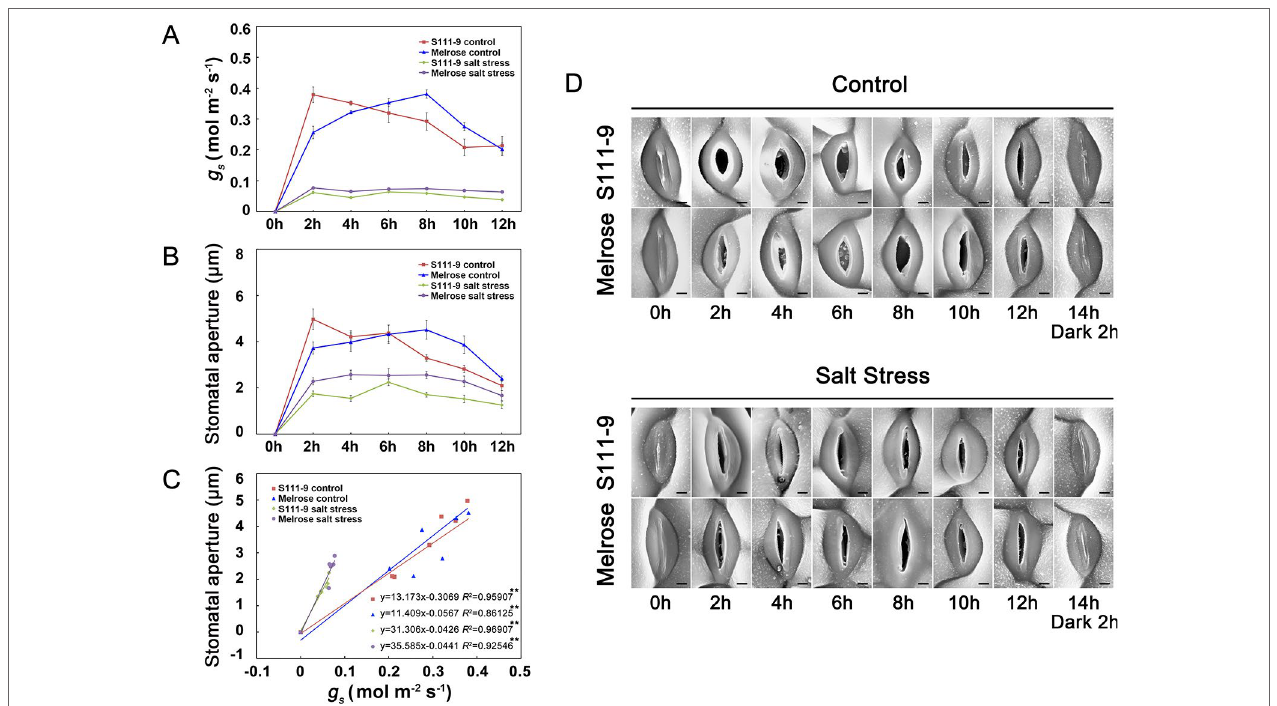
FIGURE 2 | Application of the plant surface impression technique (PSIT) to study stomatal aperture and the correlation between stomatal conductance and stomatal aperture. The third fully expanded leaves of 25-day-old Melrose and S111-9 under no salt stress and 150 mM salt stress for 0, 2, 4, 6, 8, 10, and 12 h were used in this experiment. (A) Effect of salt stress on stomatal conductance (g s ). The g s were measured with a portable photosynthesis system ( Licor -6400; LICOR Inc., Lincoln, NE, USA) equipped with a LED red blue light source. All measurements were carried out at photon flux density (PFD) of 1,200 μmol m -2 s -1 , a leaf temperature of 25°C, CO 2 of 400 ± 5 μmol mol -1 , and relative humidity of 70% in the sample chamber (mean ± SD, n = 3). (B) Effect of salt stress on stomatal aperture. SEM images at 1,500× magnification by the PSIT were used for stomatal aperture determination, which were measured by Image J software. In total, 40 stomata were measured from at least three leaves of independent seedlings at each time point, and these were repeated at three biological replicates for statistical analysis (mean ± SD, n = 3). (C) Correlation analysis between g s and stomatal aperture under the control or salt stress condition. The analysis data were obtained from (A , B) . (D) Effects of salt stress on stomatal aperture in both soybean varieties (S111-9 and Melrose) by the PSIT. All sections were observed under SEM at 1,500× magnification. Scale bar = 3 μm; n refers to number of biological replicates. ** - extremely significant difference ( P < 0.01).